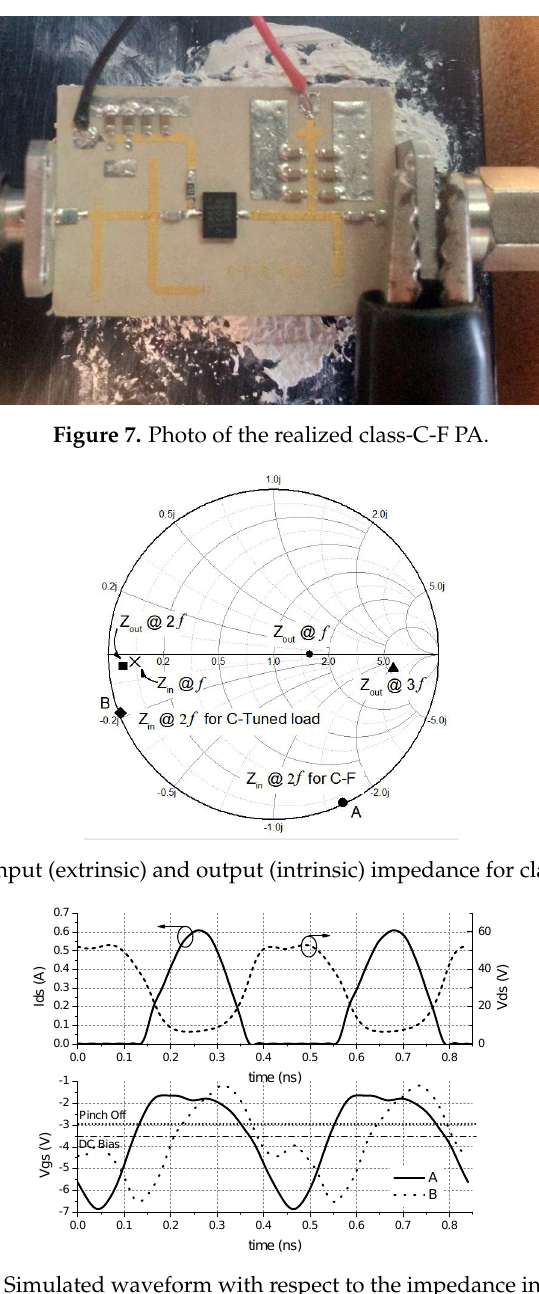
Figure 9. Simulated waveform with respect to the impedance in Figure 8.